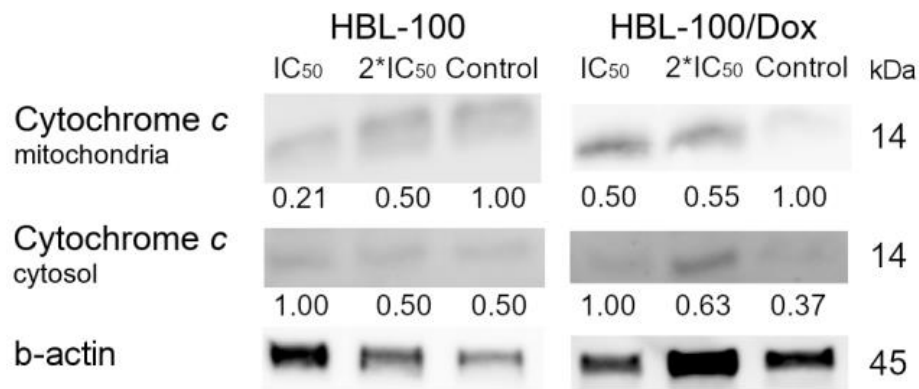
Figure 9. Western blot analysis of the expression of cytochrome c in HBL-100 and HBL-100/Dox cells after OA treatment for 16 h. β -Actin was used as loading control.